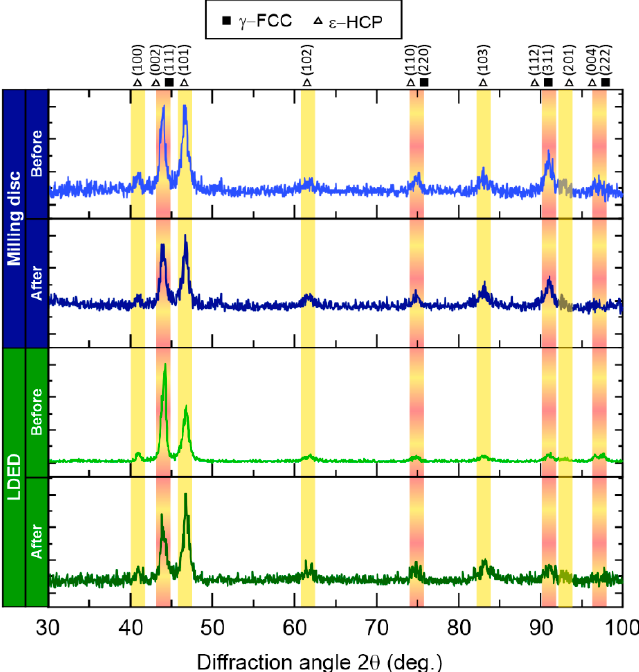
Figure 7. X-ray diffraction patterns of both milling disc and LDED techniques before and after fur- nace veneering cycles. γ -FCC (square symbol, red band) and ε -HCP (triangle symbol, yellow band) phases’ peak angles are highlighted.